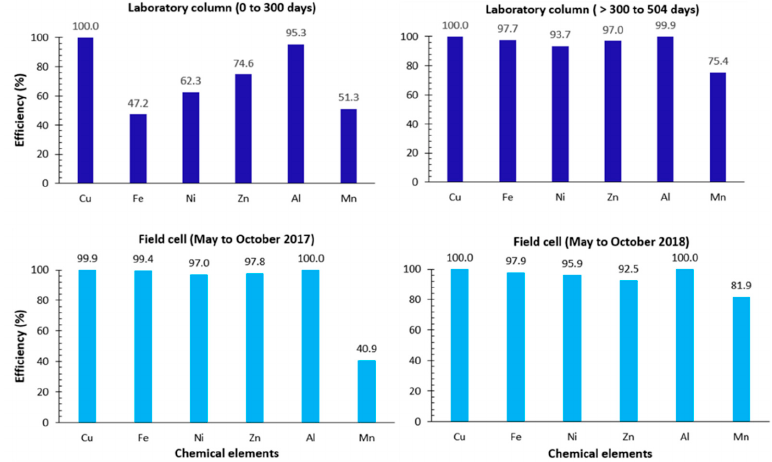
Figure 13. Efficiency with respect to limiting contaminant production for the CCBE column and field cell.